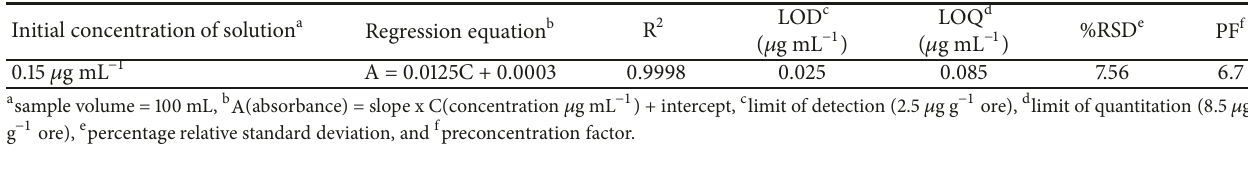
Table 3: Determination of Au in CMC ore sample and Gold Ore (MA-1b)